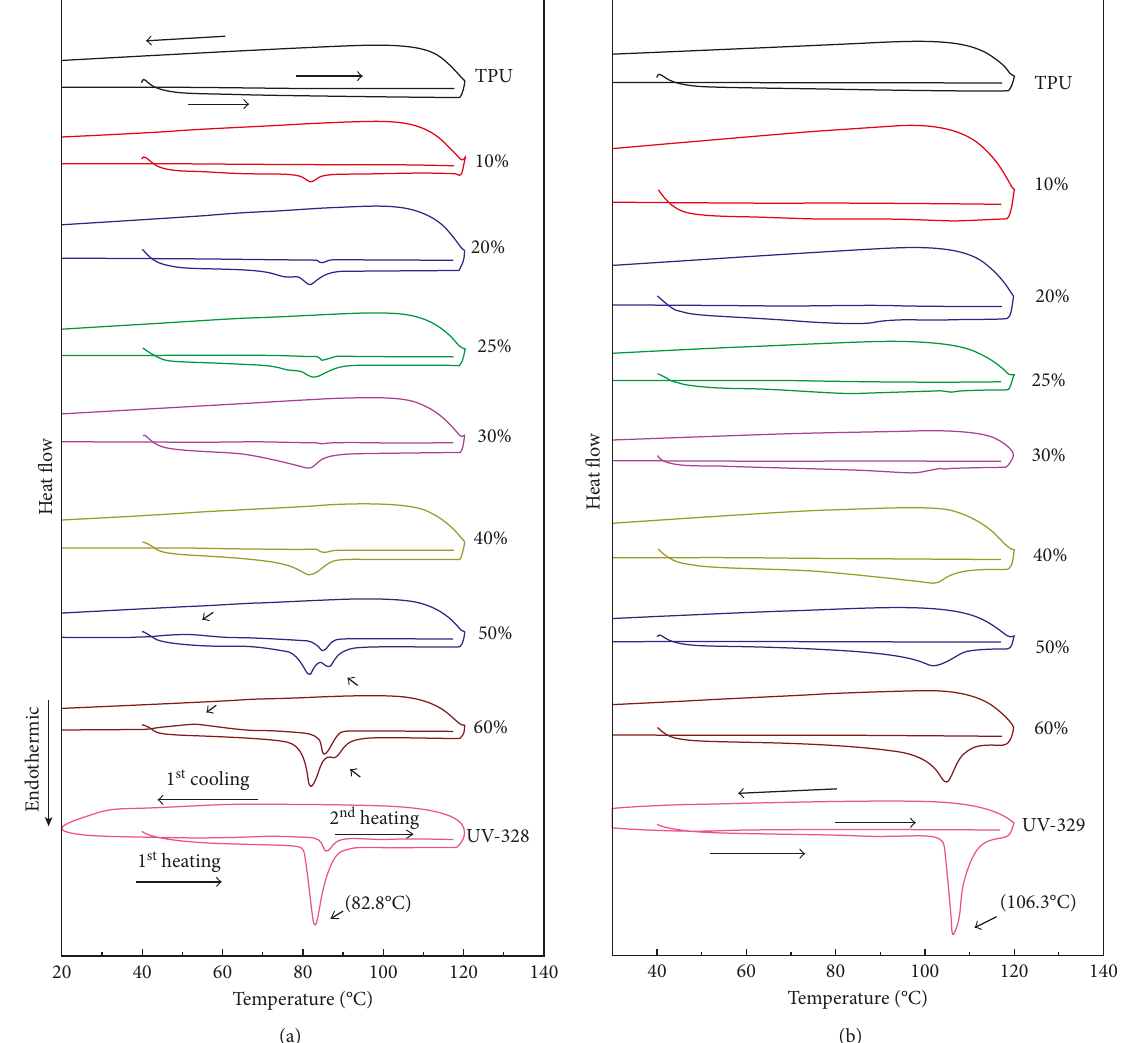
Figure 3: DSC curves of (a) 328-composites and (b) 329-composites with different mass ratios of